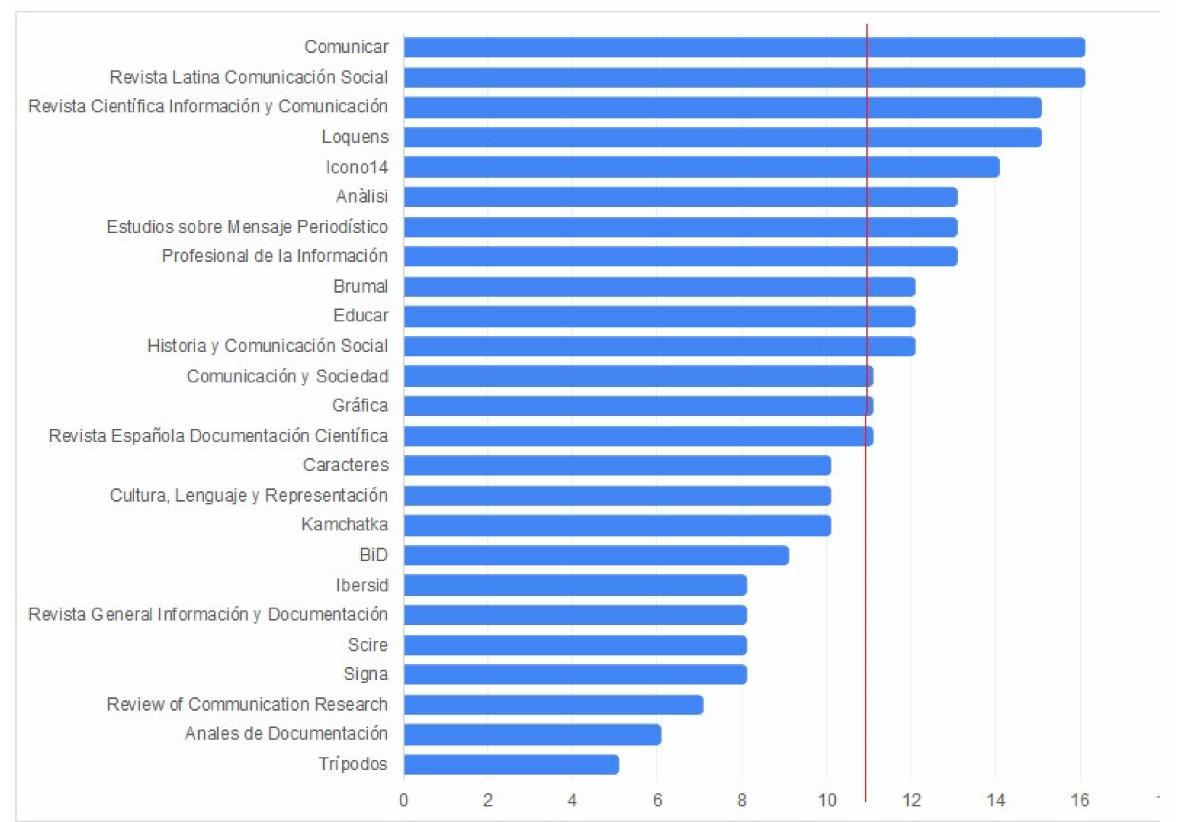
Figure 3. Journals’ compliance with indicators